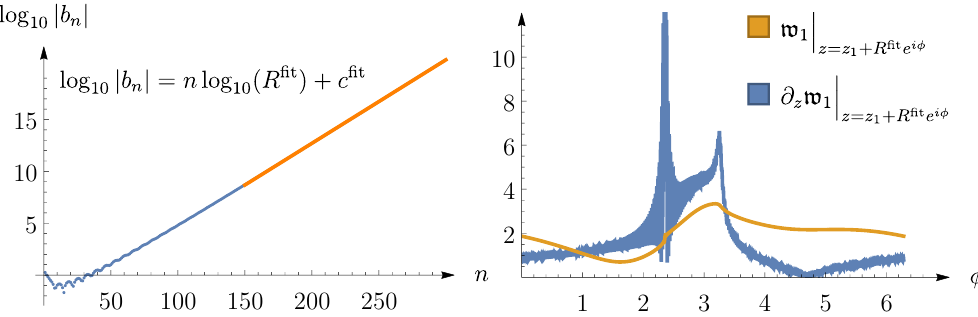
Figure 11. Plots determining the nature of the obstruction to convergence of the series represen- tation (4.14) of w 1 ( z ) . Left: calculation of the radius of convergence R fit of (4.14) by the root test method. For the linear fit, we again use only the second half of all calculated coefficients. Right: plot of the series representations of w 1 ( z ) and ∂ z w 1 ( z ) , for z = z 1 + R fit e iφ , where φ ∈ [0 , 2 π ] . One can identify the local maxima of the derivative with the two closest branch points. The larger and more prominent (‘divergent’) peak corresponds to z ∗ and the smaller to z 2 . The branch point z 2 is 1 located outside the convergence disk of the